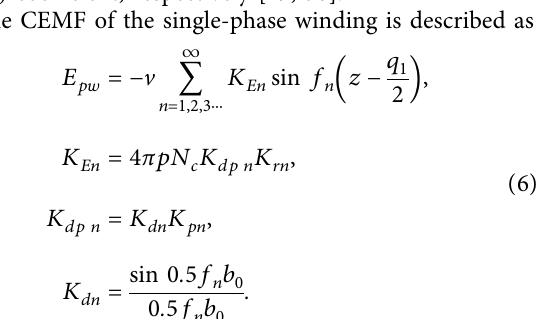
Figure 5: CEMF of single-phase coil